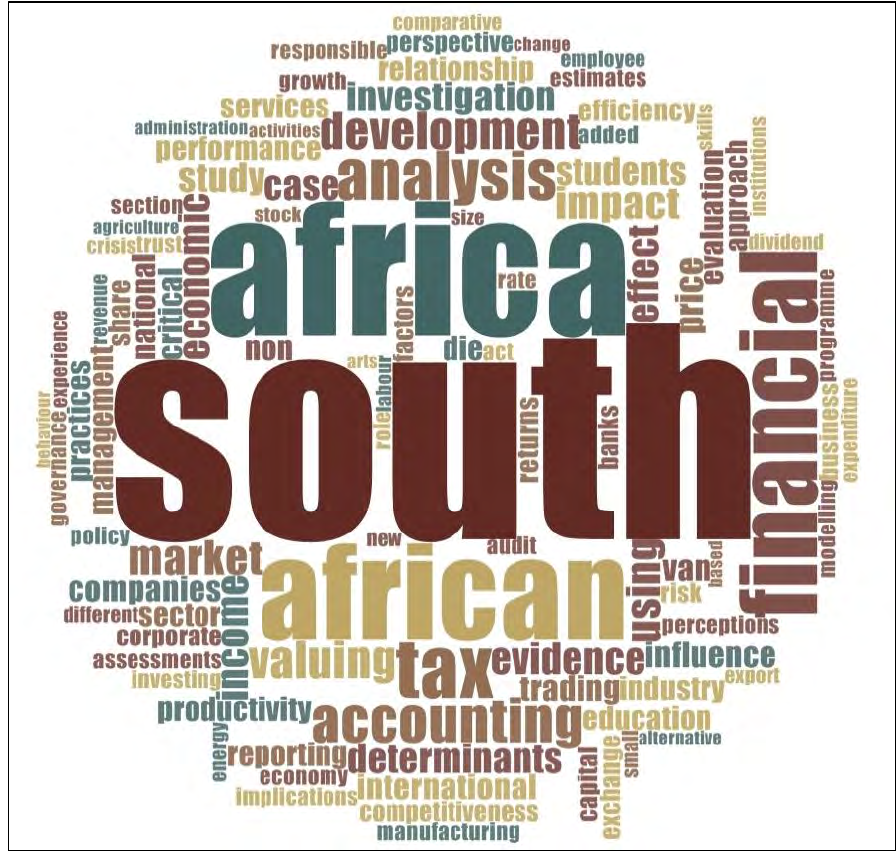
FIGURE 2: Word frequency cloud (Titles) Source: